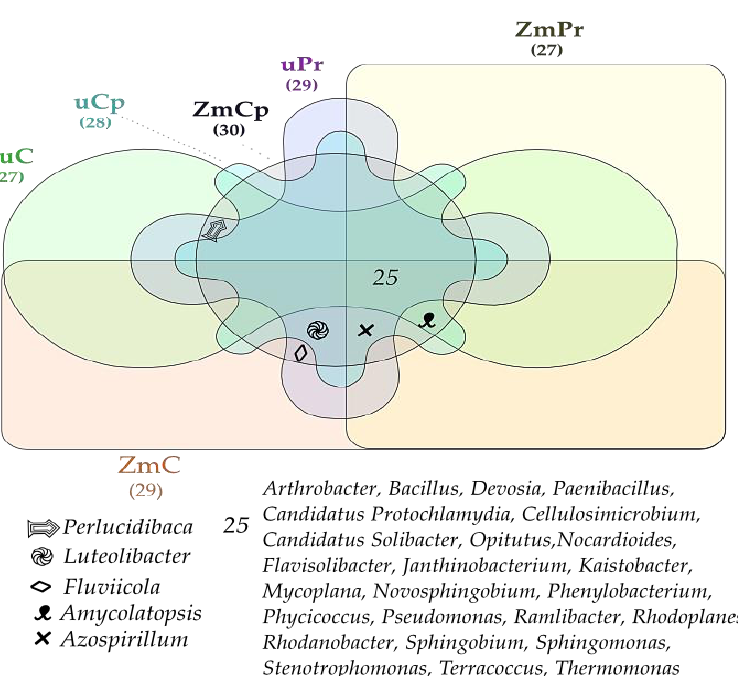
Figure 7. Venn diagram showing common and unique types of bacteria in the soil. uC—contaminated unsown soil; uPr—sown soil contaminated with permethrin; uCp—sown soil contaminated with cypermethrin; ZmC—uncontaminated soil sown with Zea mays ; ZmPr—soil sown with Zea mays contaminated with permethrin; ZmCp—soil sown with Zea mays contaminated with cypermethrin. All soils samples were abundantly populated by Arthrobacter , Bacillus , Candidatus , Protochlamydia , Candidatus , Solibacter , Cellulosimicrobium , Devosia , Flavisolibacter , Janthinobac- terium , Kaistobacter , Mycoplana , Nocardioides , Novosphingobium , Opitutus , Paenibacillus , Pheny- lobacterium , Phycicoccus , Pseudomonas , Ramlibacter , Rhodanobacter , Rhodoplanes , Sphingobium , Sphingomonas , Stenotrophomonas , Terracoccus , and Thermomonas . The dominant bacteria identified in the analyzed soil samples were Sphingomonas (clone 3214512, 1052559, 237613, 1048605) and Bacillus (clone New.ReferenceOTU111, 593219, 578257) (Figure 8). The high- est OTU number (8482) of the first mentioned bacteria clone was found in the soil not contaminated with insecticides and not sown with Zea mays . The contamination of bare soil with cypermethrin reduced its OTU number to 4830, and with permethrin, to 444. In turn, Zea mays cultivation contributed to its OTU number increase to 2150 in the soil treated with permethrin and to its OTU number decrease to 361 in the soil amended with cypermethrin. The remaining clones of Bacillus predominated in the bare soil contaminated with